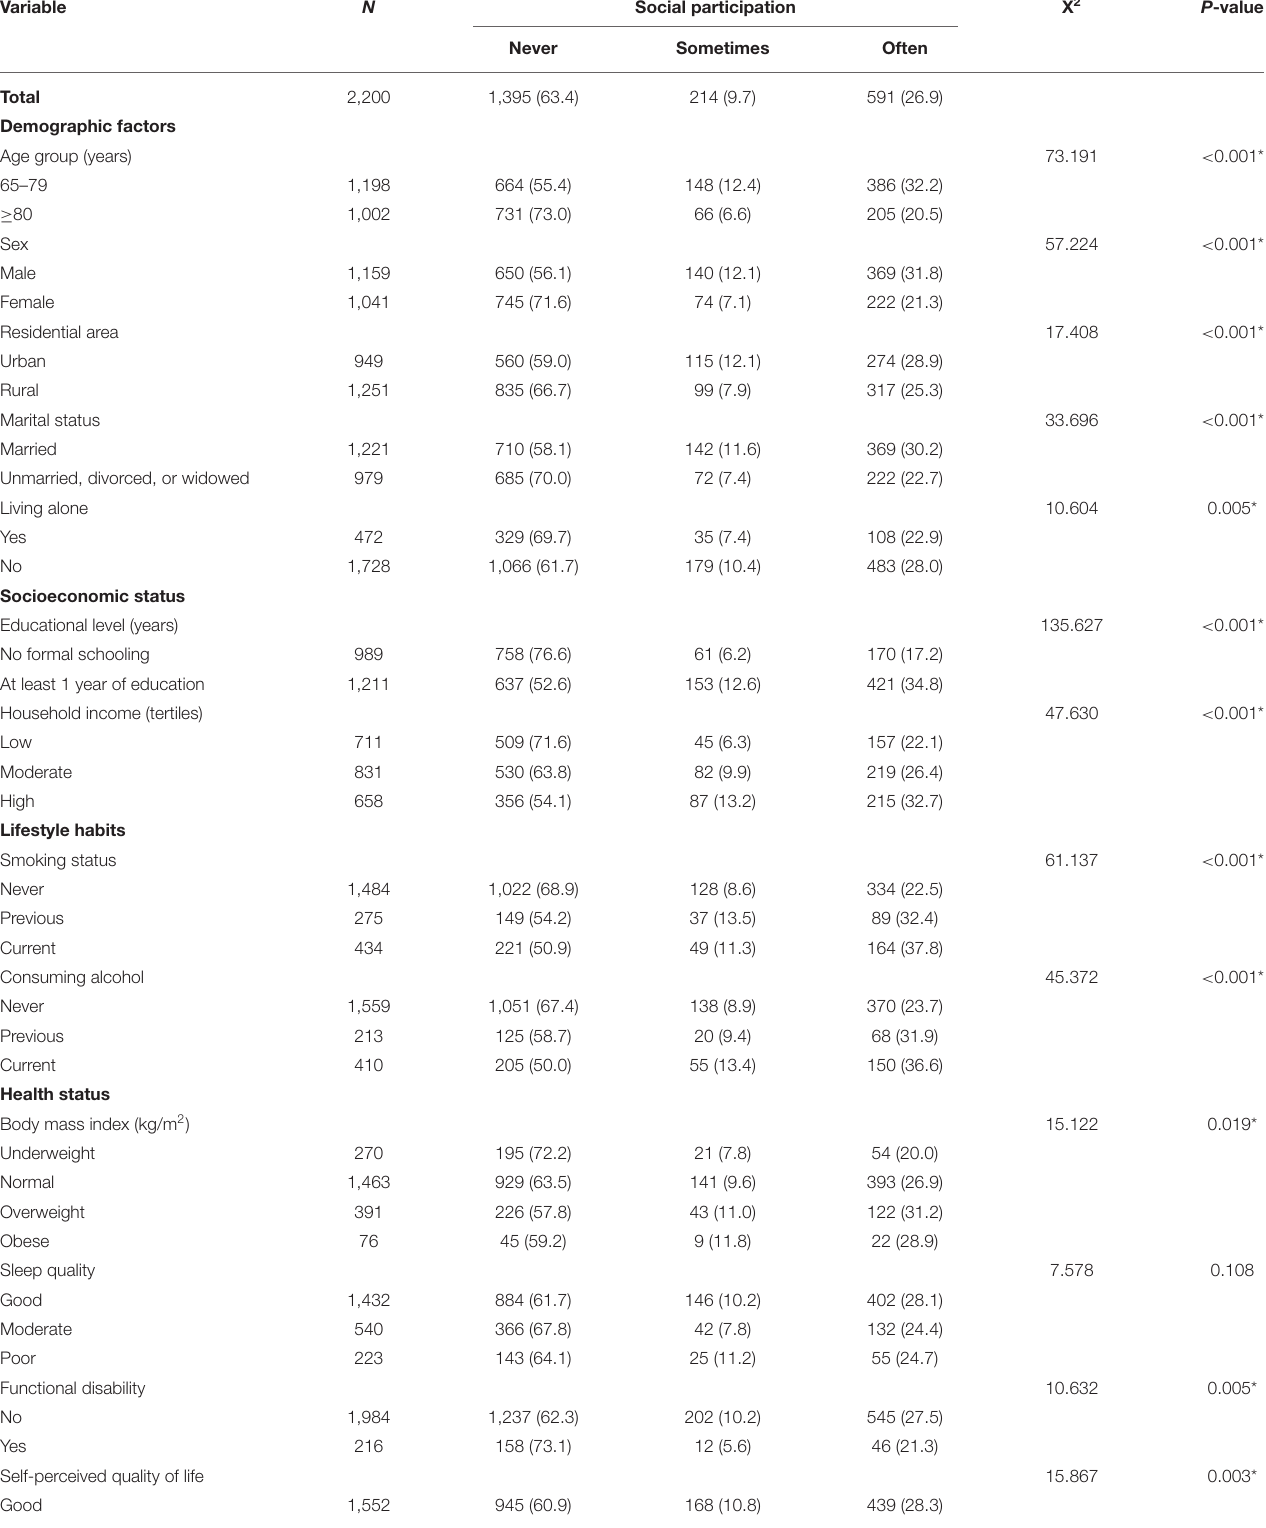
TABLE 1 | Social participation by demographic factors, socioeconomic status, lifestyle habits, and health status. Variable N Social participation X 2 P